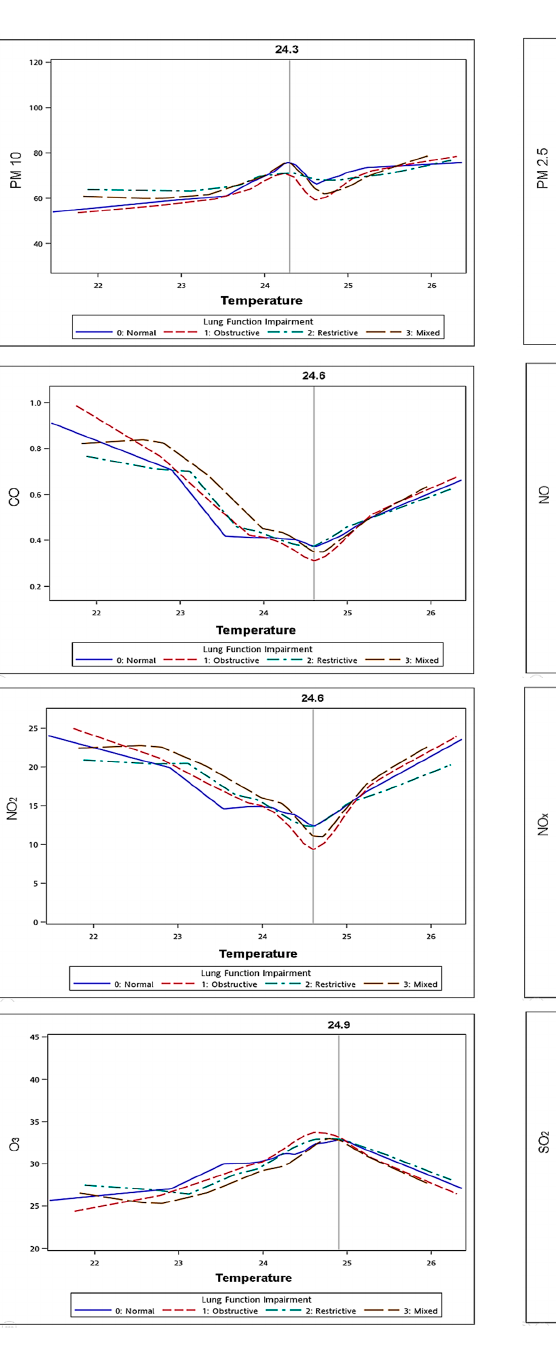
Figure 1. Plot of Temperature and Air pollutants in four groups.